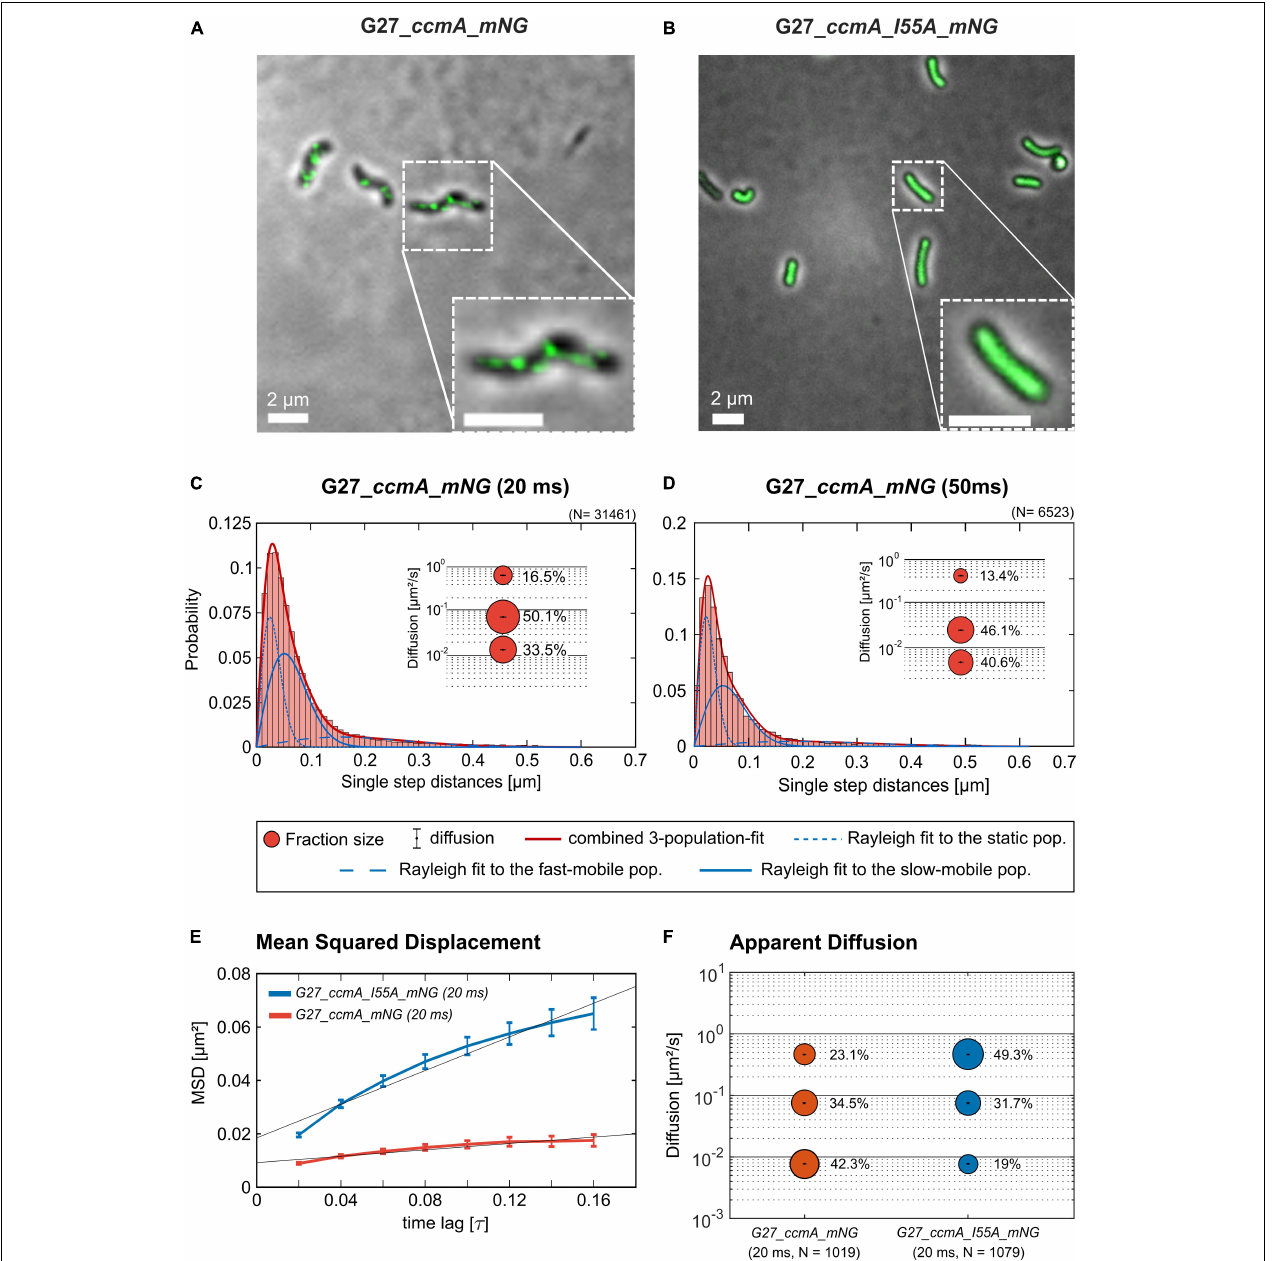
FIGURE 4 | Structured illumination microscopy imaging of CcmA_mNG (A) and CcmA_I55A_mNG (B) in G27 at exponential phase, scale = 2 µ m. Polymeric CcmA forms distinct foci at the membrane as shown by Z-projection while its mutated derivate CcmA_I55A is distributed equally over the cell (microscope settings mNG: 488 nm laser, 10.0%, exp. time: 20 ms, 3 rotations, EMCCD gain: 50.0). (C,D) Squared displacement analysis (SQD) of CcmA_mNG with an exposure time of 20 (C) and 50 ms (D) per frame of single-molecule tracks as obtained from slim-field bleaching microscopy. Diagrams display the probability for each detected jump distance with non-simultaneous SQD curve fitting. Data acquired with 50-ms exposure time represent one replicate. (E) Mean-squared displacement curves with an aligned linear fitting to the first 9 time lags showing a general diffusion regardless of subdiffusion. The MSD analysis demonstrates that the inhibited polymerization of CcmA_I55A results in an overall faster movement. (F) Apparent diffusion analysis of CcmA_mNG and CcmA_I55A_NG in G27 of single-molecule tracks obtained from slim-field bleaching microscopy. Bubble plots show the estimated population and diffusion coefficients as identified by simultaneous APPD curve fitting. Data derived from at least three biological triplicates with an exposure time of 20 ms per frame. CcmA_I55A_mNG (126 cells, N = 1,079 tracks) exhibited a strong shift to the mobile population as compared to CcmA_mNG (113 cells, N = 1,019 tracks) while the slow-mobile population remain unaffected, suggesting a functional state represented by the static